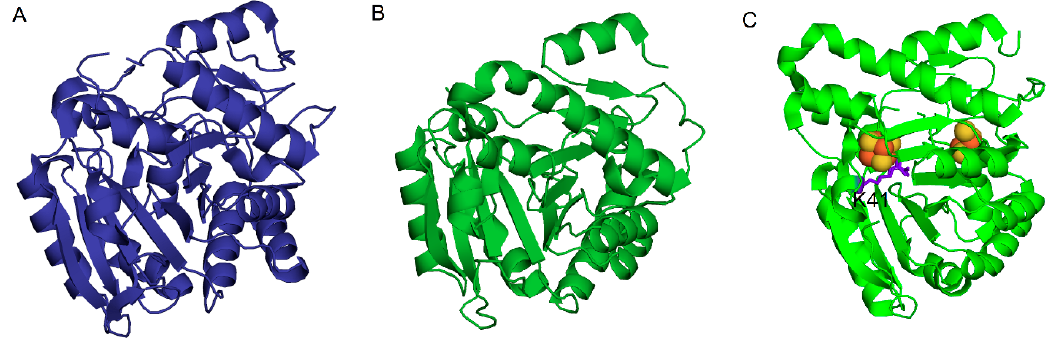
Figure 1. Crystal structures of Taw1. ( A ) Apo structure of P. horikoshii (PDB 2XY0). ( B ) Apo structure of M. jannaschii (PDB 2Z2U). ( C ) M. jannaschii structure with lysine-pyruvate adduct (PDB 6DJT). K41 adduct with pyruvate (purple sticks) and the [4Fe–4S] clusters (yellow-brown spheres) are depicted and labeled. Figures 1–3 were made using PyMOL (https://pymol.org/2/).